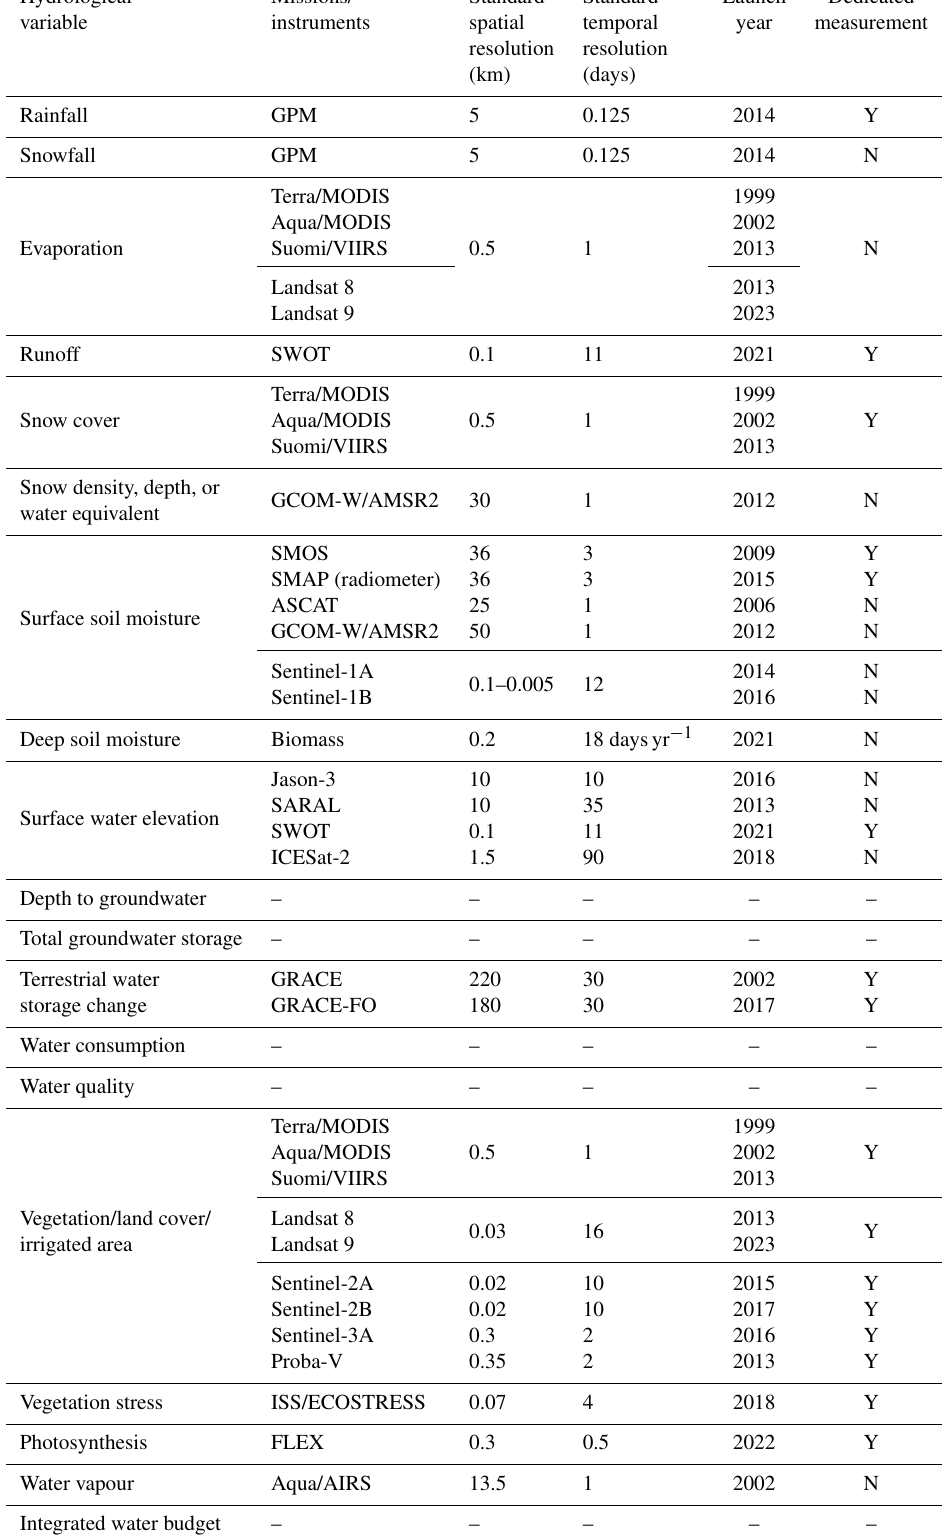
Table 1. Hydrological variables and the current and planned satellite remote sensing missions that can be used to estimate them. We note that this list is not necessarily comprehensive and that there are possible trade-offs between resolution and accuracy that are not explicitly accounted